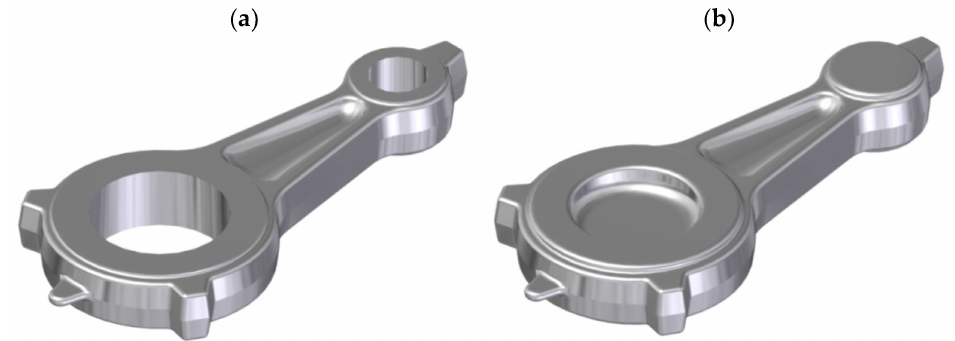
Figure 1. Three-dimensional model of the finished connecting rod part ( a ) and the designed connect- ing rod forging ( b ).